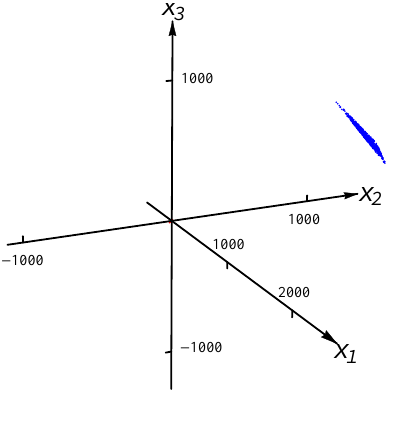
Figure 6. Sample from one Student t distribution with 10% artificial outliers.